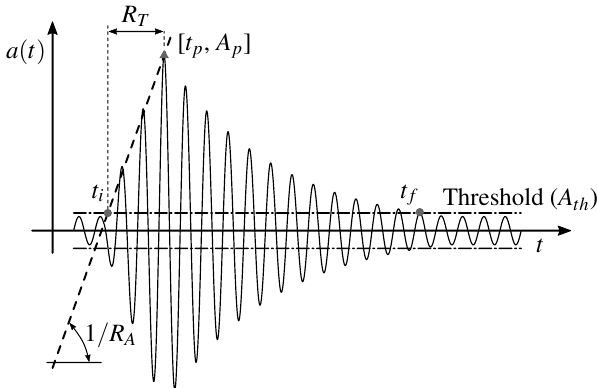
Figure 2. Typical AE signal with its parameters of